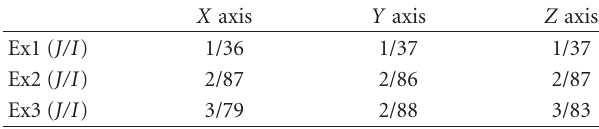
Table 5: Subspace dimension ( J/I ) in intermodel experiments. X axis Y axis Z